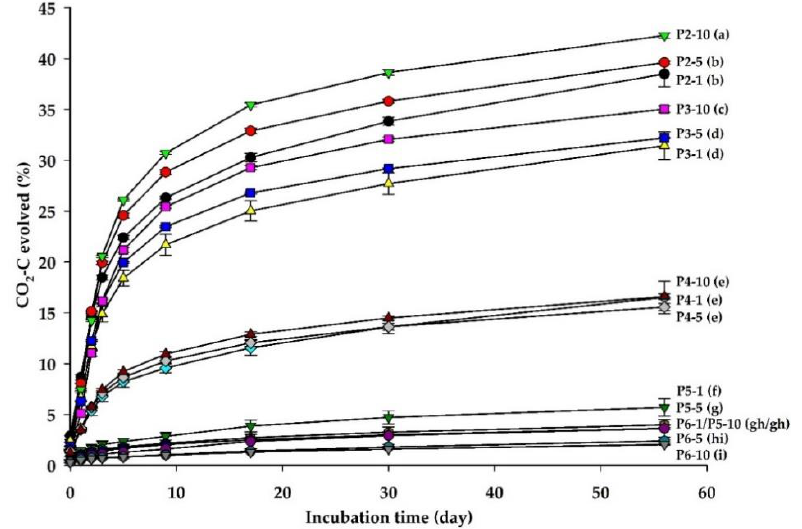
Figure 3. Cumulative amounts of applied C mineralized (ACM) evolved as CO 2 – C in the different treatments during the incubation. Values represent means ( n = 5) ± standard deviation (error bars). The different lowercase letters in parentheses indicate significant differences ( p < 0.05) between treatments at the end of the incubation (56-d).